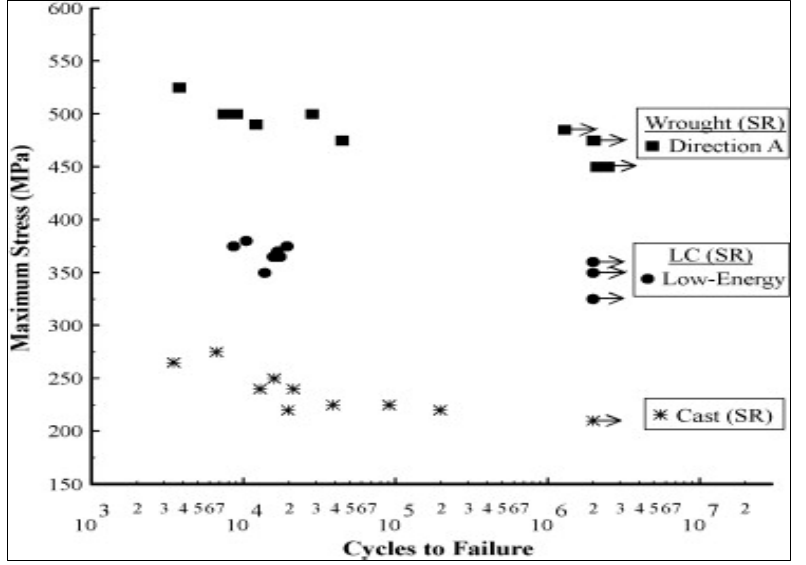
Figure 13. Fatigue life data of IN-625 in air at 650 °C under a stress-controlled sinusoidal waveform (R = 0.1, f = 60 Hz) LC(SR) = Direct laser deposited + Stress relieved (adapted with permission from Ref. [49] 2009, Elsevier).